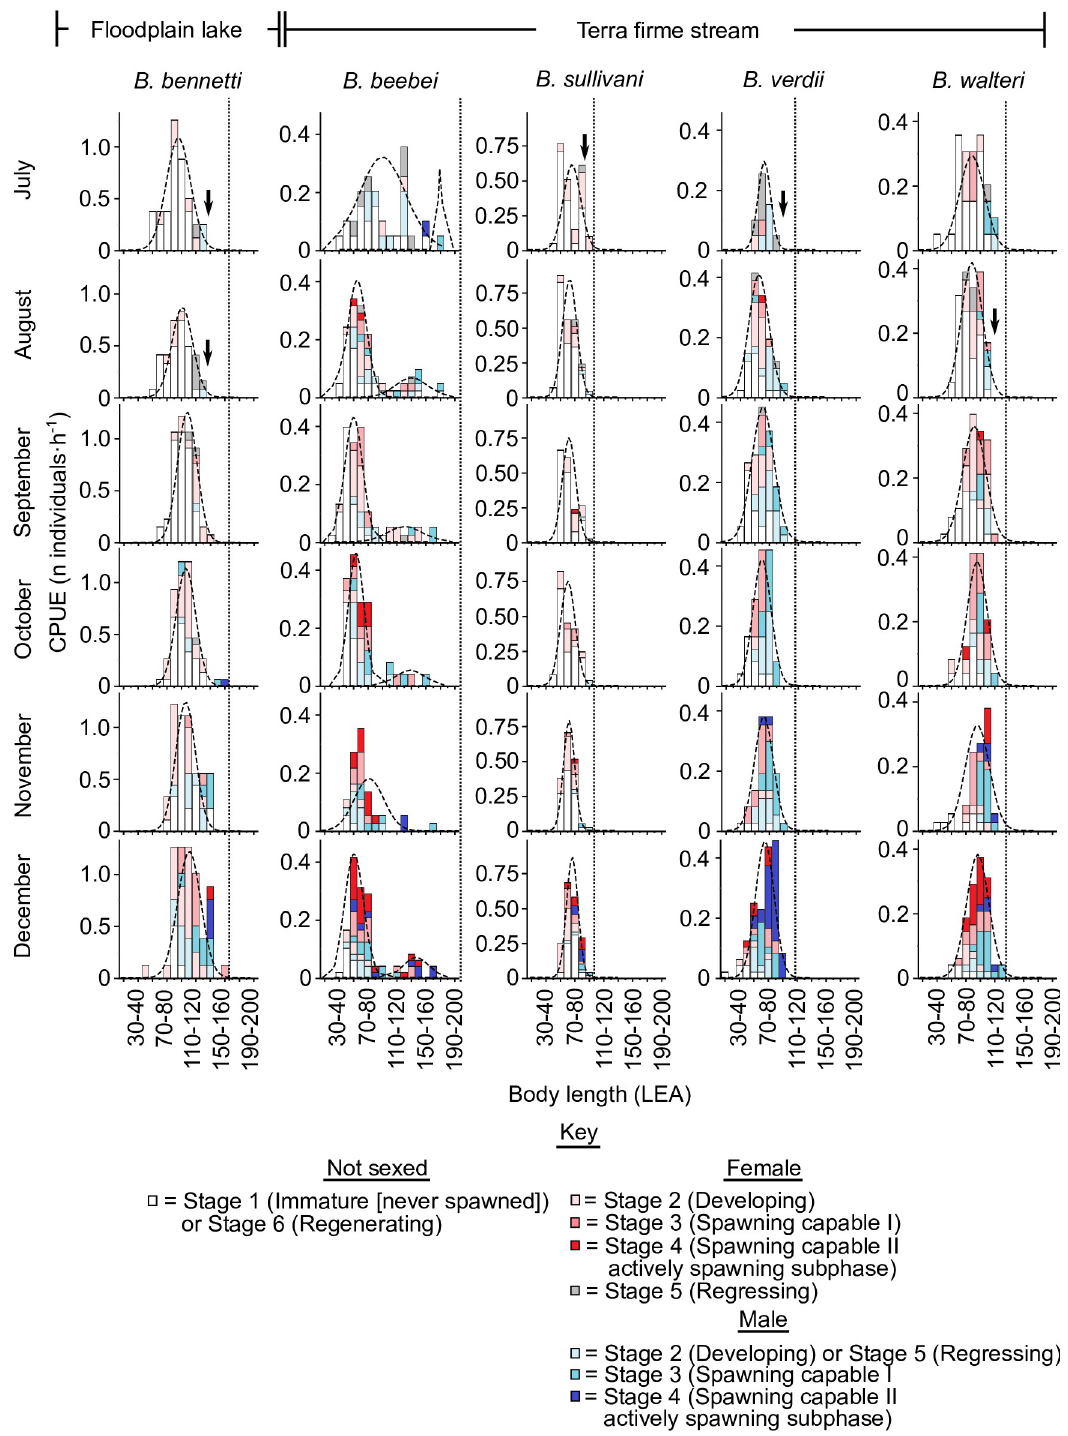
Fig 4. July–December monthly size-frequency distributions for five species of Brachyhypopomus with Gaussian distributions fitted by finite mixture models to show modal size groups. CPUE = capture per unit effort. Vertical dotted lines report maximum body size as length to anal-fin terminus (LEA). Vertical arrows indicate reduction/disappearance of large adult size classes in the late breeding season. Stage 6 (regenerating) individuals are confined to the 1+ year group of B . beebei .